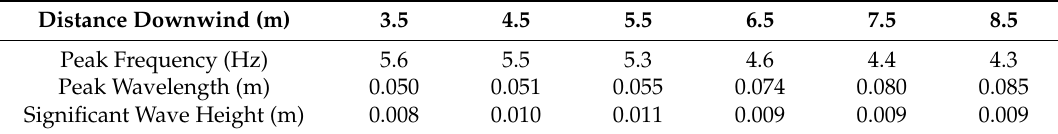
Table 2. Key parameters obtained from the capacitive wave staff measurements.